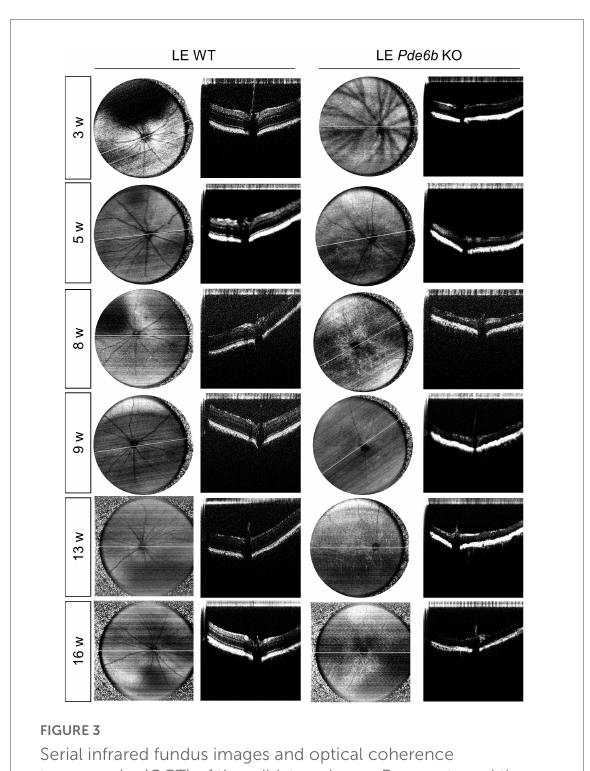
FIGURE3 Serial infrared fundus images and optical coherence tomography (OCT) of the wild-type Long–Evans rats and the Pde6b -knockout Long–Evans rats. Representative infrared fundus images and OCT shows progressive thinning of the Pde6b -knockout (LE Pde6b KO) retina compared with wild-type Long–Evans rats (LE WT) rat over a period of 16